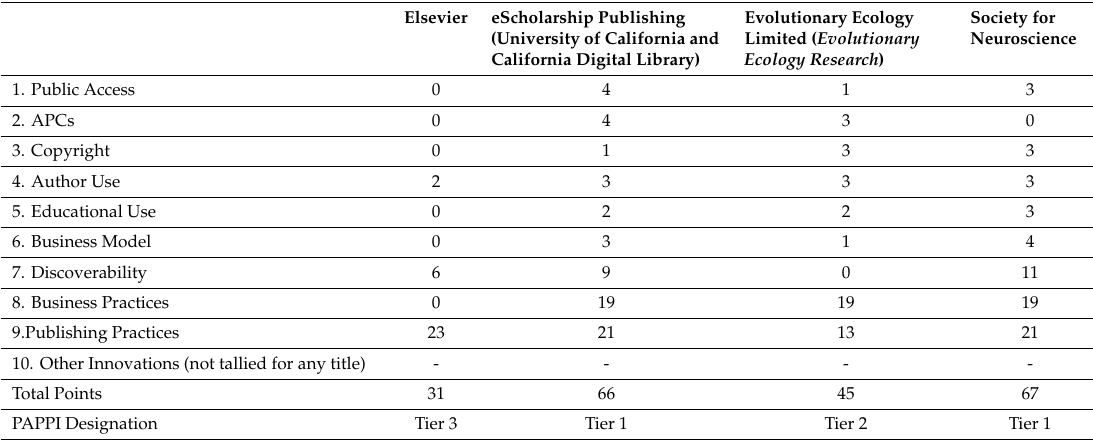
Table 2. Scores for selected